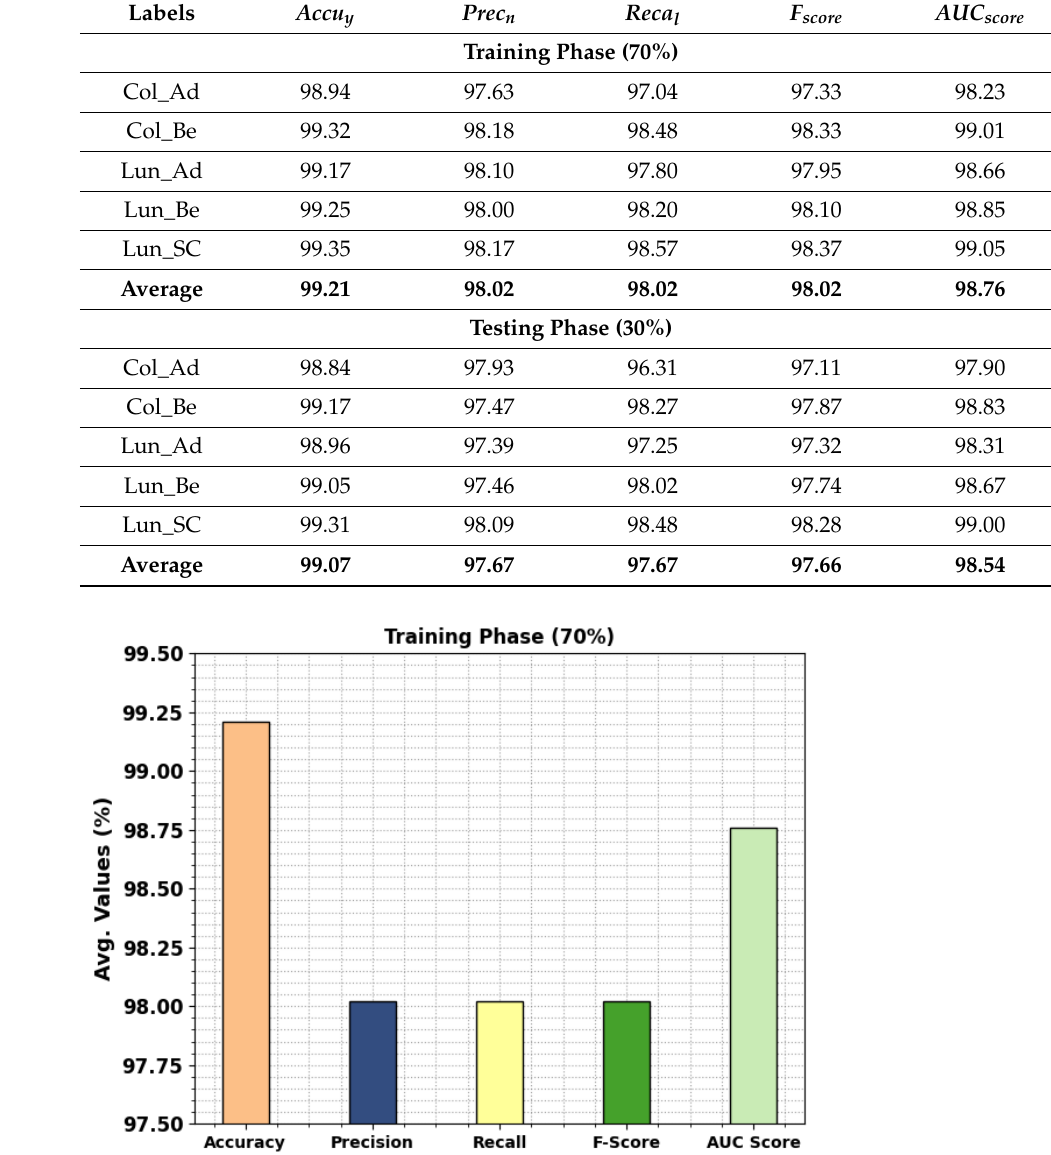
Table 3. Classifier outcomes of MPADL-LC3 approach on TRS/TSS of 70:30. Labels